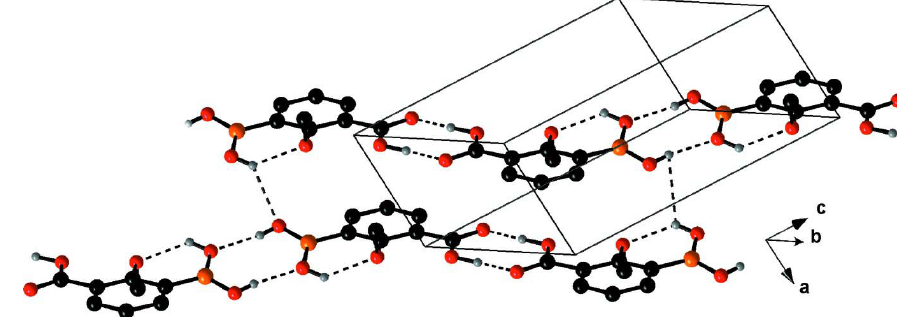
Figure 2 The hydrogen-bonding pattern for (I). Hydrogen bonds are shown as dashed